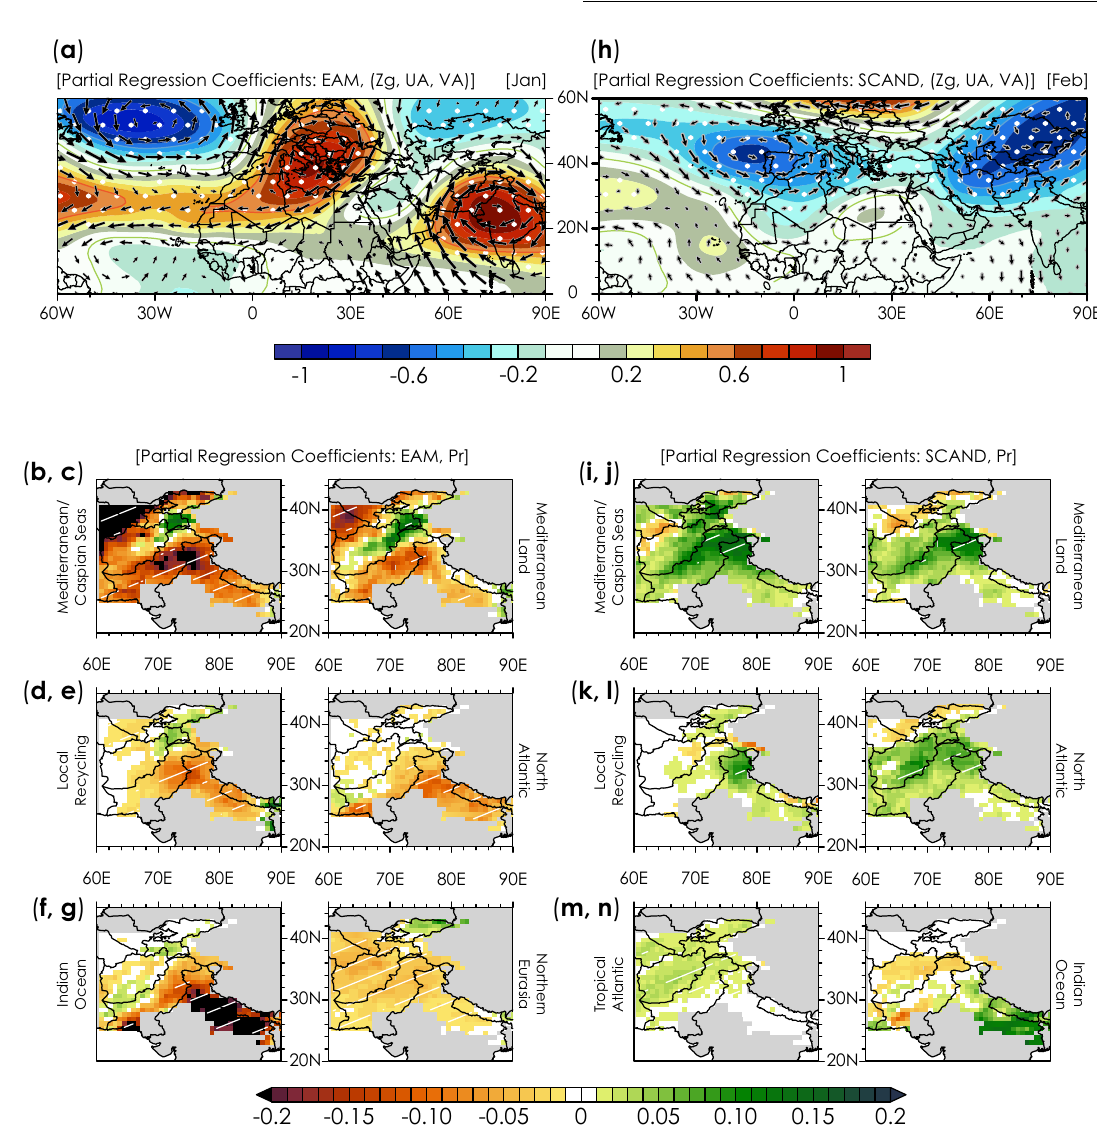
Fig. 6 Standardized partial regression coef fi cients associated with the EAM and SCAND in the multi-linear regression models. Standardized partial regression coef fi cients of 200 mb geopotential height, zonal and meridional winds ( a ), and regionally recycled precipitation ( b – g ) on the EAM index in January. Six selected evaporative source regions exhibit the most prominent statistically signi fi cant relationship. ( h – n ) Same as in ( a – g ) but for SCAND in February. Standardization of regionally recycled precipitation is with respect to the total recycled precipitation. Stippling represents statistical signi fi cance at a 90% con fi dence